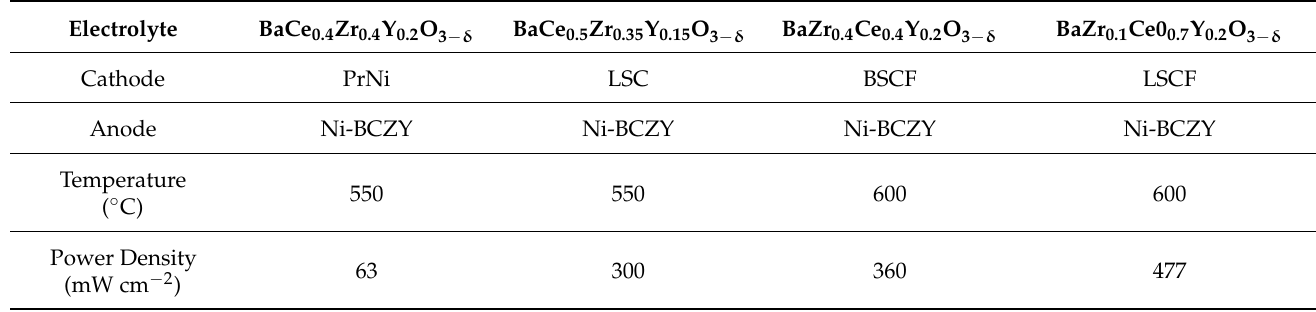
Table 1. Power Densities of SOFC with different compositions of BCZY electrolyte [46].